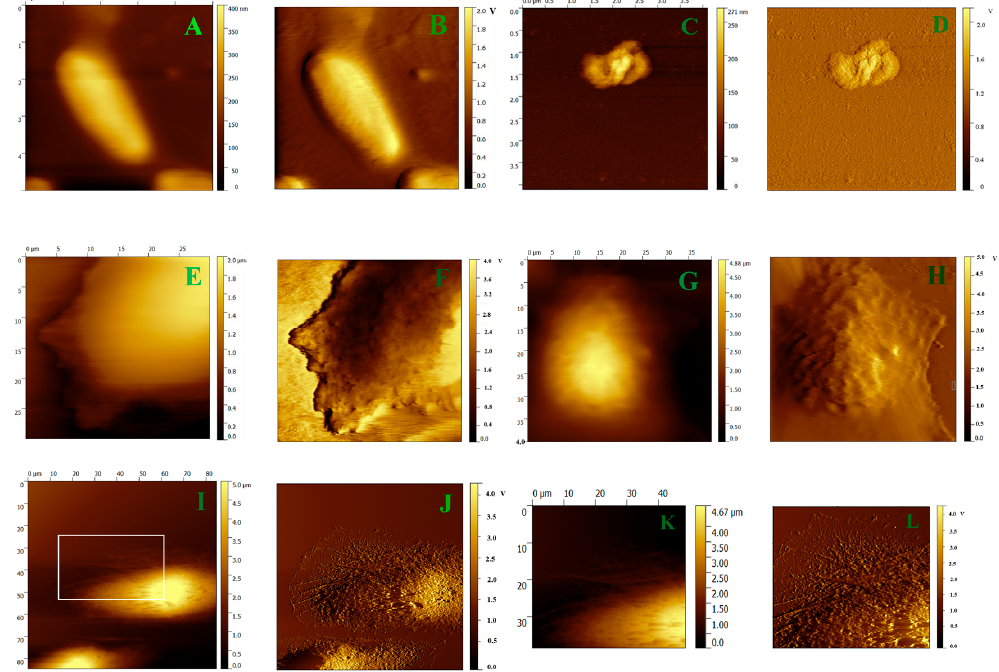
Figure 4. Representative AFM topographic and amplitude images of E. coli and HeLa cell membranes before, and after, interaction with the parent peptide V13K. Panel ( A ) shows a topographic image of E. coli ; Panel ( B ) shows the amplitude image corresponding to Panel ( A ); Panel ( C ) shows a topographic image of E. coli interacting with the peptide V13K; Panel ( D ) shows the amplitude image corresponding to Panel ( C ); Panel ( E ) shows a topographic image of an unfixed HeLa cell; Panel ( F ) shows the amplitude image corresponding to Panel ( E ); Panel ( G ) shows a topographic image of a HeLa cell fixed by 4% paraformaldehyde; Panel ( H ) shows the amplitude image corresponding to Panel ( G ); Panel ( I ) shows a topographic image of HeLa interacting with the peptide V13K; Panel ( J ) shows the amplitude image corresponding to Panel ( I ); Panel ( K ) shows magnification of the membrane in Figure 4I; Panel ( L ) shows the amplitude image corresponding to Panel ( K ).